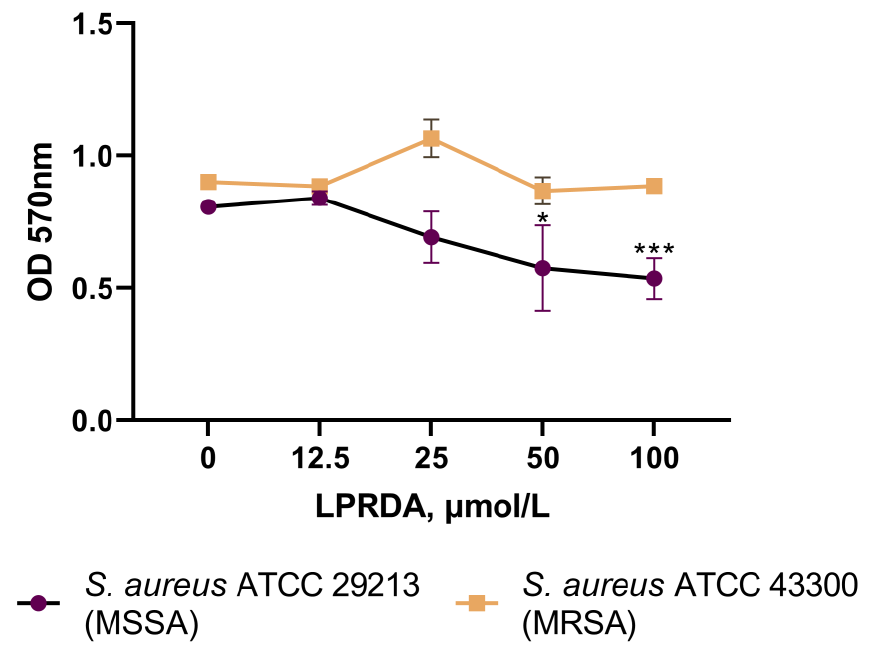
Figure 3. Biofilm growth of S. aureus ATCC 29213 (MSSA) and S. aureus ATCC 43300 (MRSA) strains after incubation with different LPRDA concentrations. * p < 0.05; *** p < 0.001 compared to control.